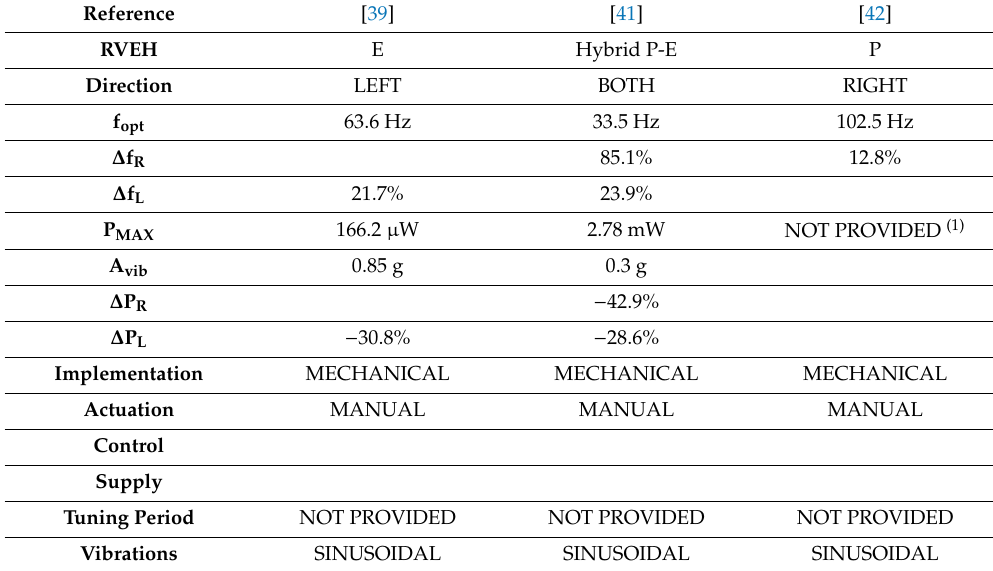
Table 6. Variable reluctance based MTTs classification indicators.